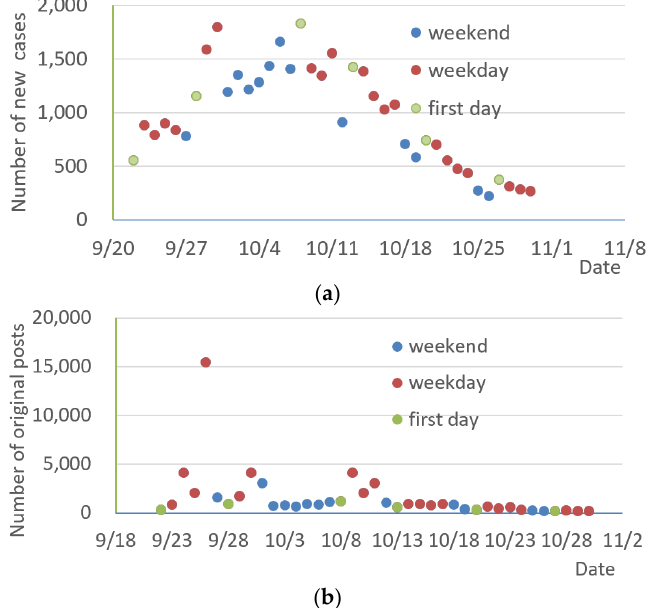
Figure 7. ( a ) Impact of new cases reported on different days of the week; ( b ) Impact of the number of Weibo posts on different days of the week.